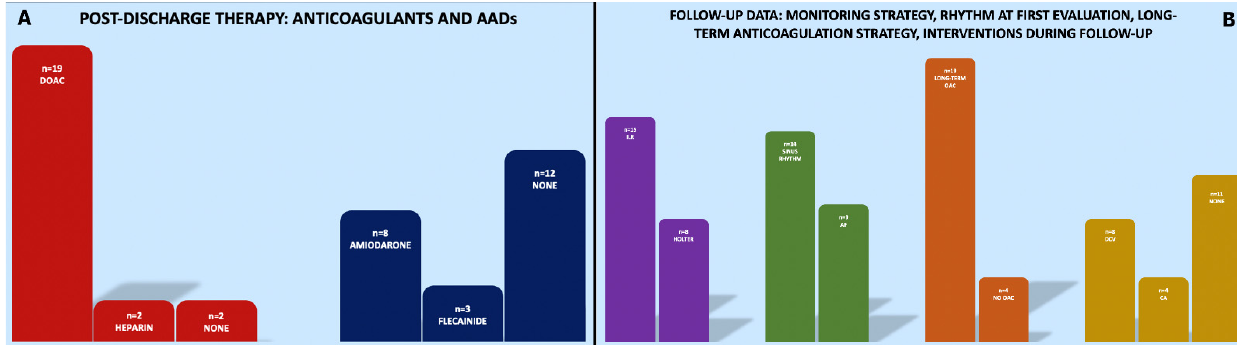
Figure 1. Clinical management of the study cohort: post-discharge therapy ( A ) and follow-up data ( B ). ( A ) Red bars summarize anticoagulant therapy at discharge: 19 patients were discharged on